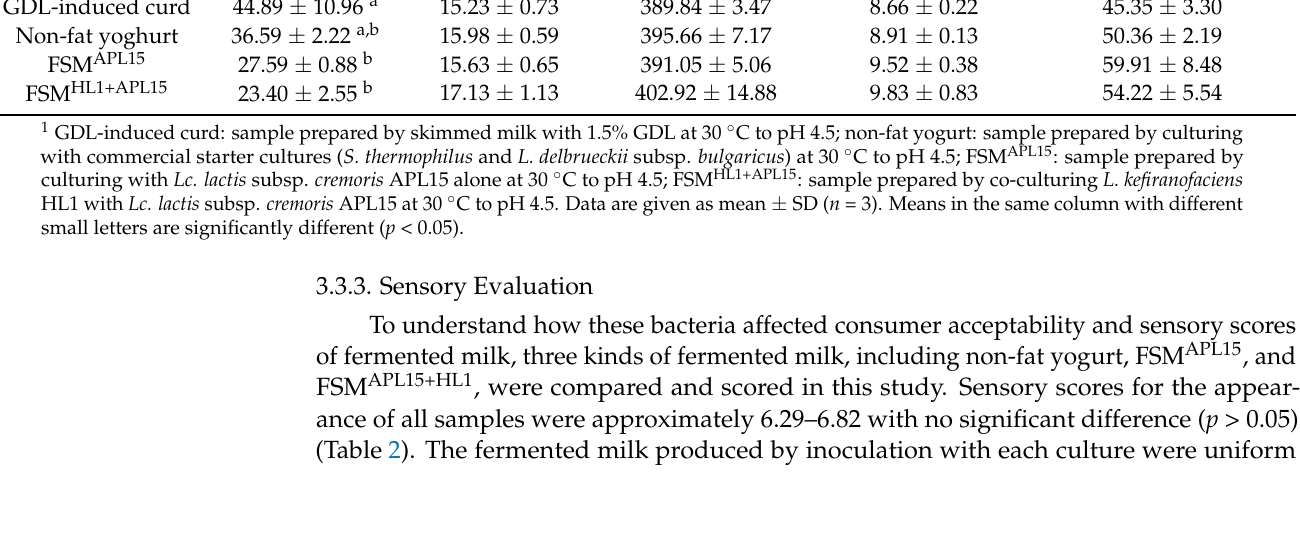
Table 1. Syneresis and texture attributes of the fermented skimmed milk samples at pH